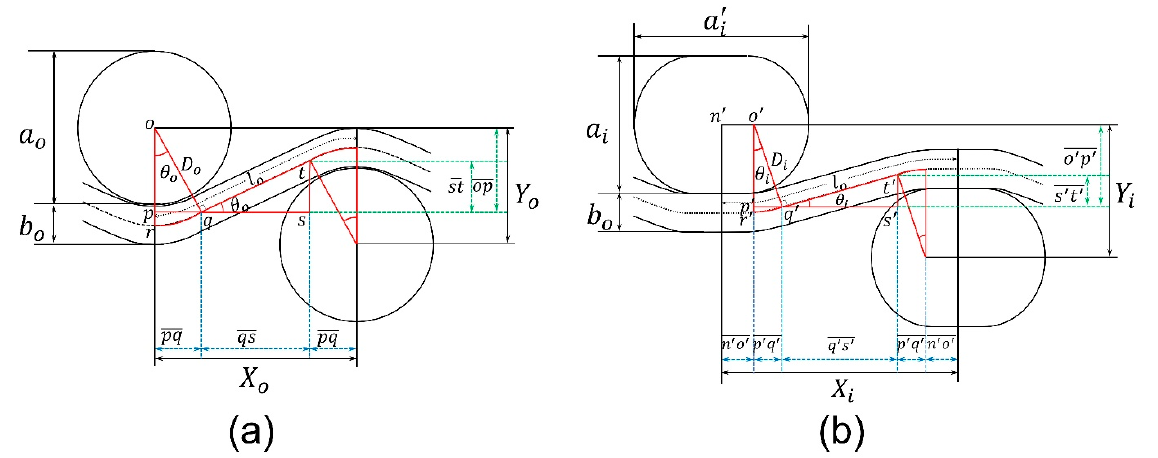
Figure 5a. Based on the above assumptions, the geometrical model of the first stage can be re-illustrated in detail, as shown in Figure 6.